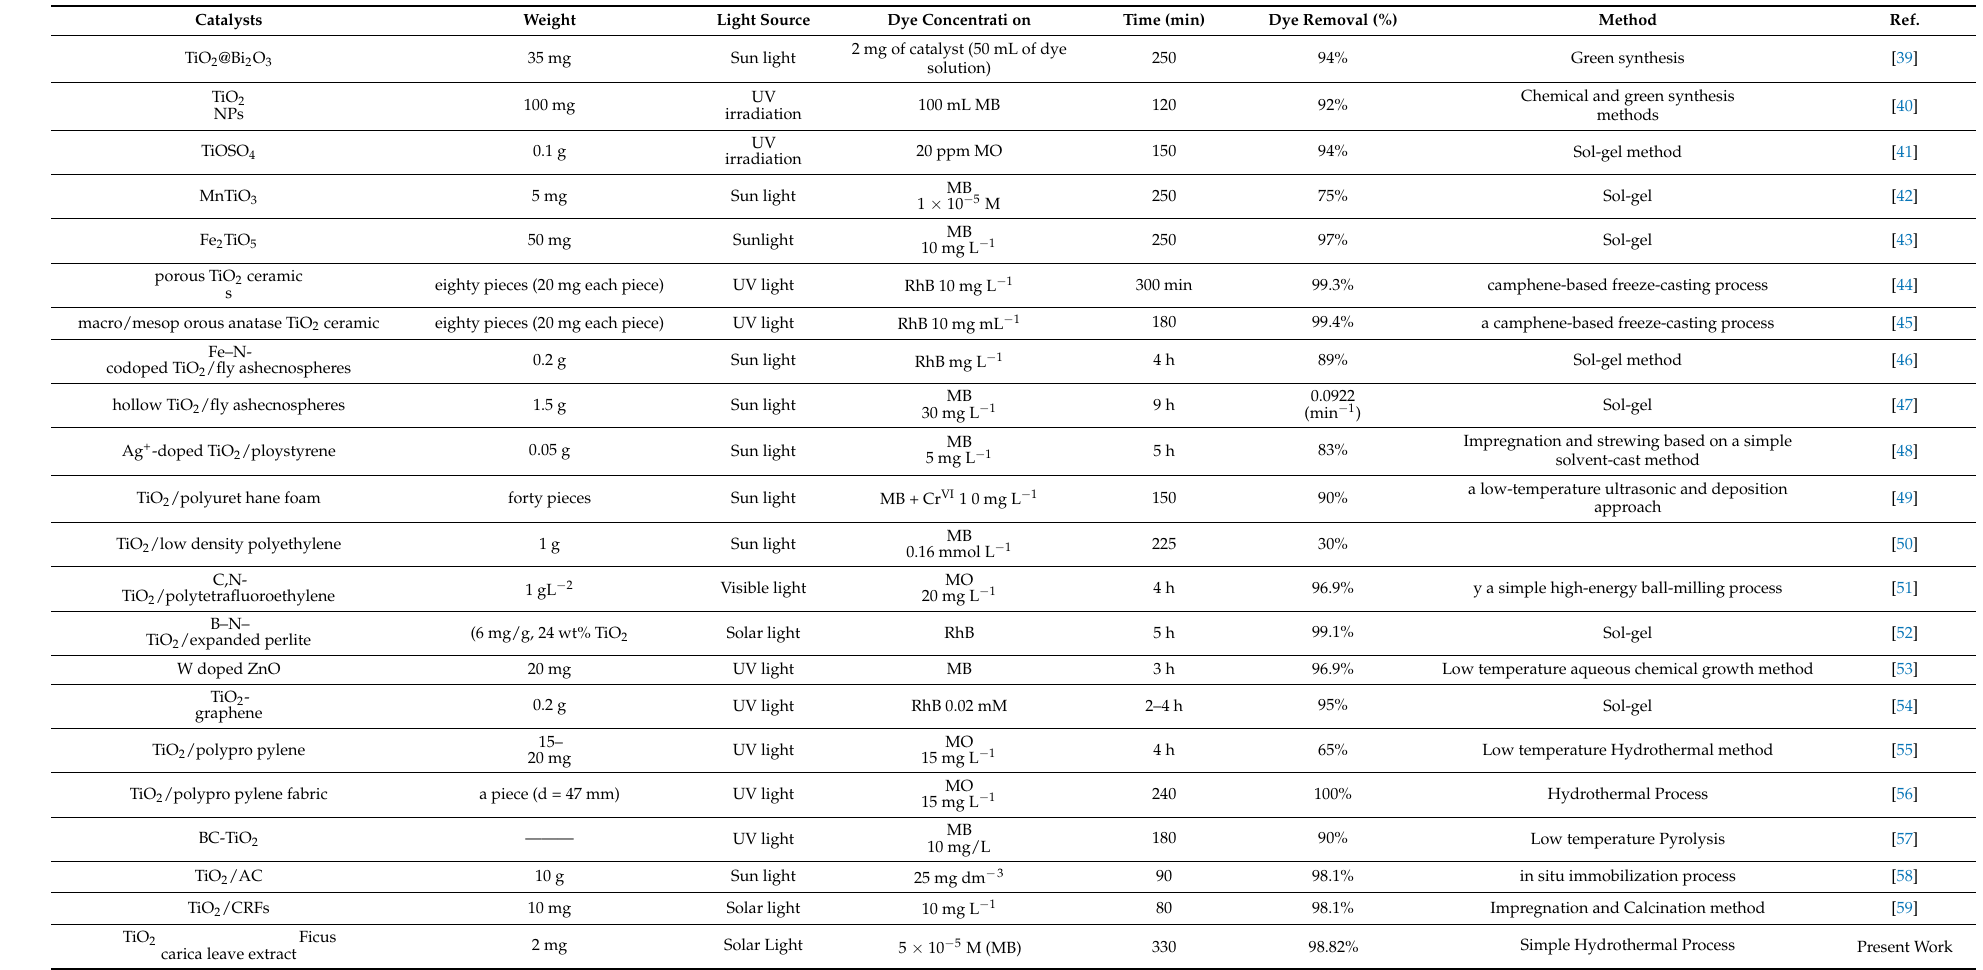
Table 2. The comparative analysis of presented results with published